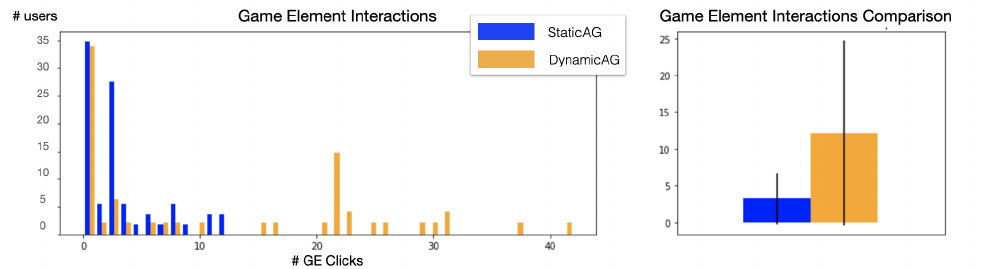
Figure 8. Comparison of GE Clicks . Left side: histogram. Right side: the mean of the number of interactions with elements and the variance of all students in each group. “# users” means number of users.